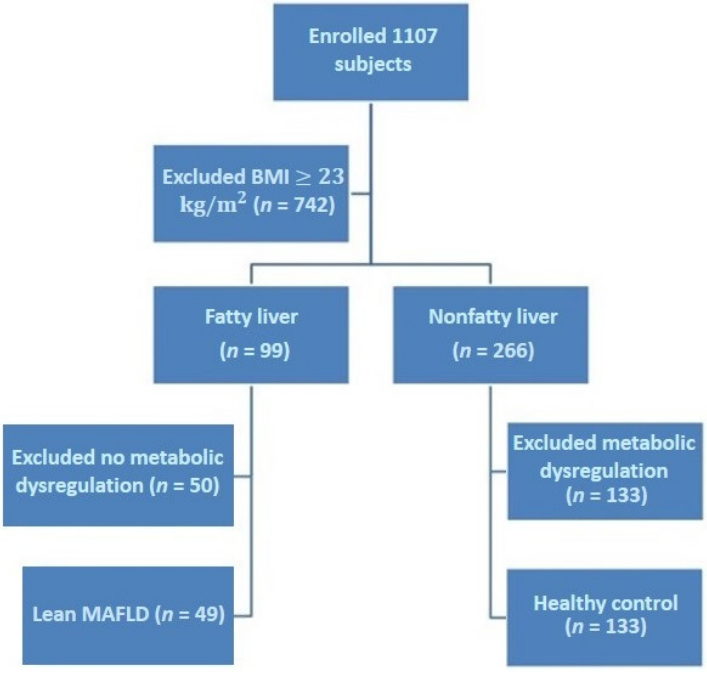
Figure 1. Flow chart of subject selection.